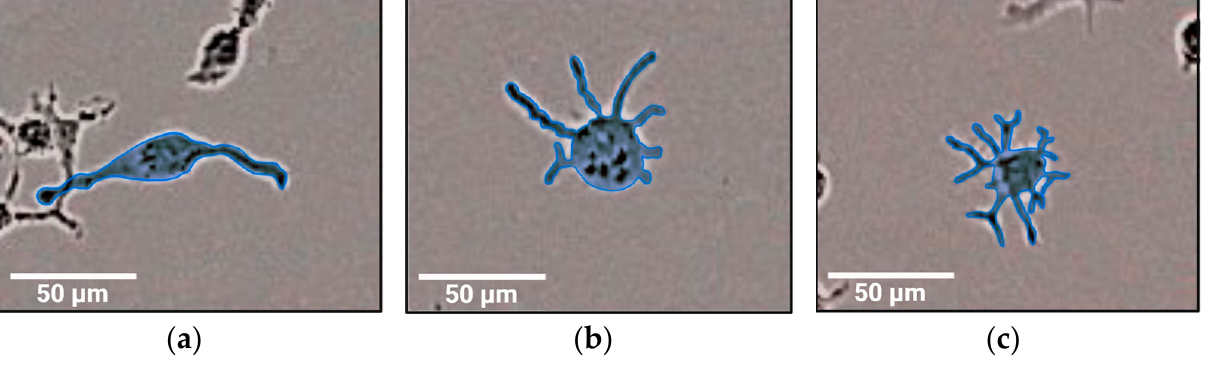
Figure 3. Morphological analysis of M1_B macrophages. Images were obtained immediately after removing the polarization stimuli for each M φ subset (for time points see Figure 1) by the IncuCyte ® ZOOM reader with 10× objective using the brightfield channel. Morphology of the cell was then outlined and highlighted in BioRender (BioRender, Toronto, ON, Canada). ( a ) Macrophage with spindle-like morphology; ( b ) macrophage with filopodia; ( c ) macrophage with numerous ramified filopodia. Created with BioRender.com; accessed on 7 th December 2022.